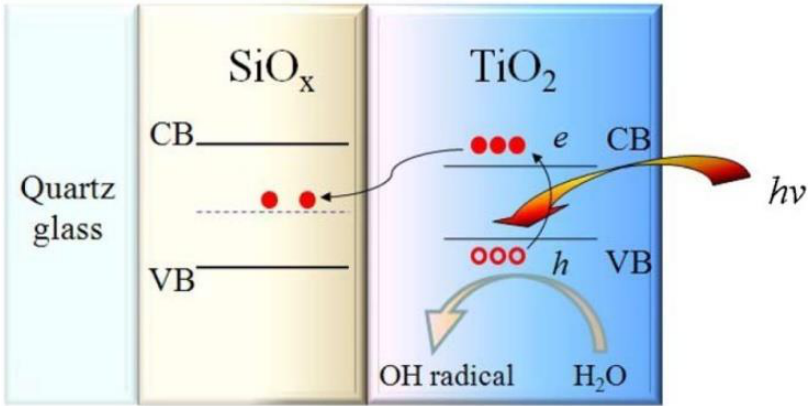
Figure 13. Schematic illustration of photocatalytic process for TiO 2 / SiO x double-layer photocatalyst. Reprinted with permission from [143], copyright 2009, Elsevier.